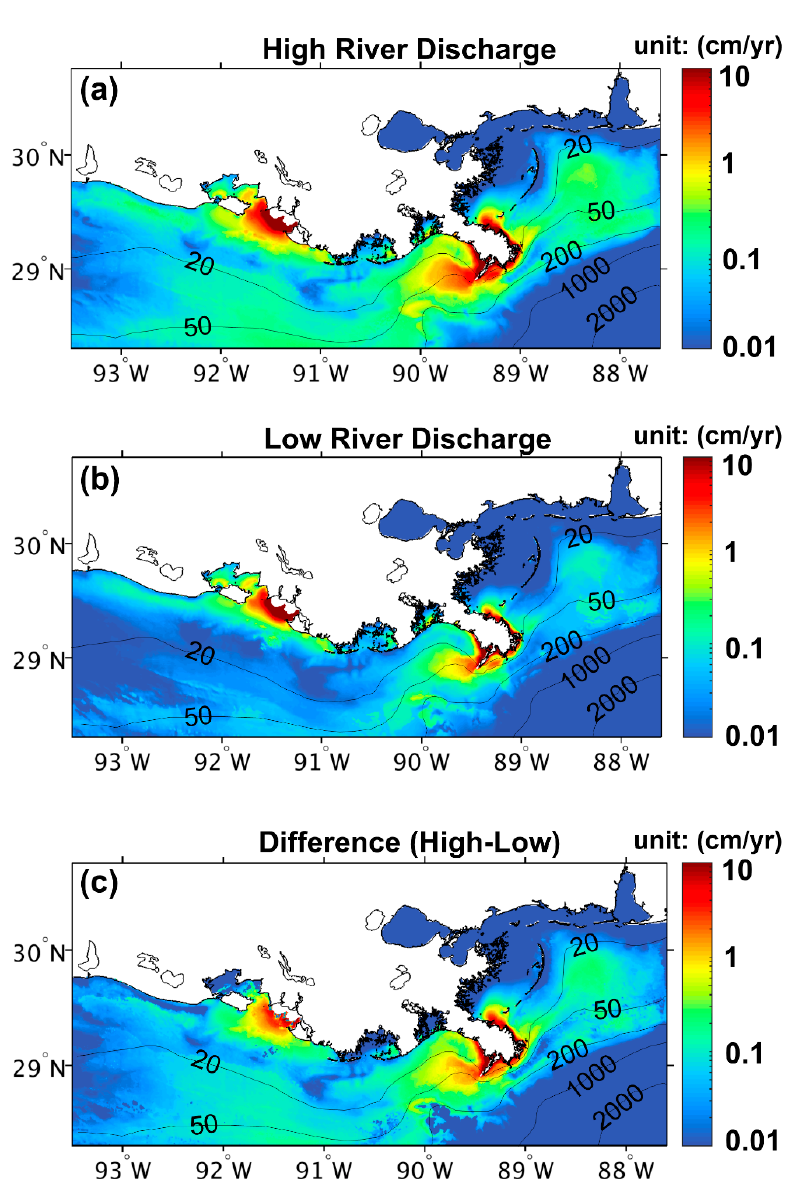
Figure 17. 20-year averaged annual sedimentation rate in the nGoM with high river discharge ( a ), low river discharge ( b ), and their difference ( c ).